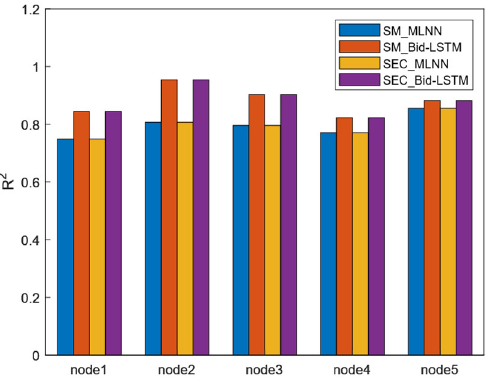
Figure 12. R 2 performance comparison results between LSTM and MLNN for the prediction of SM and SEC.